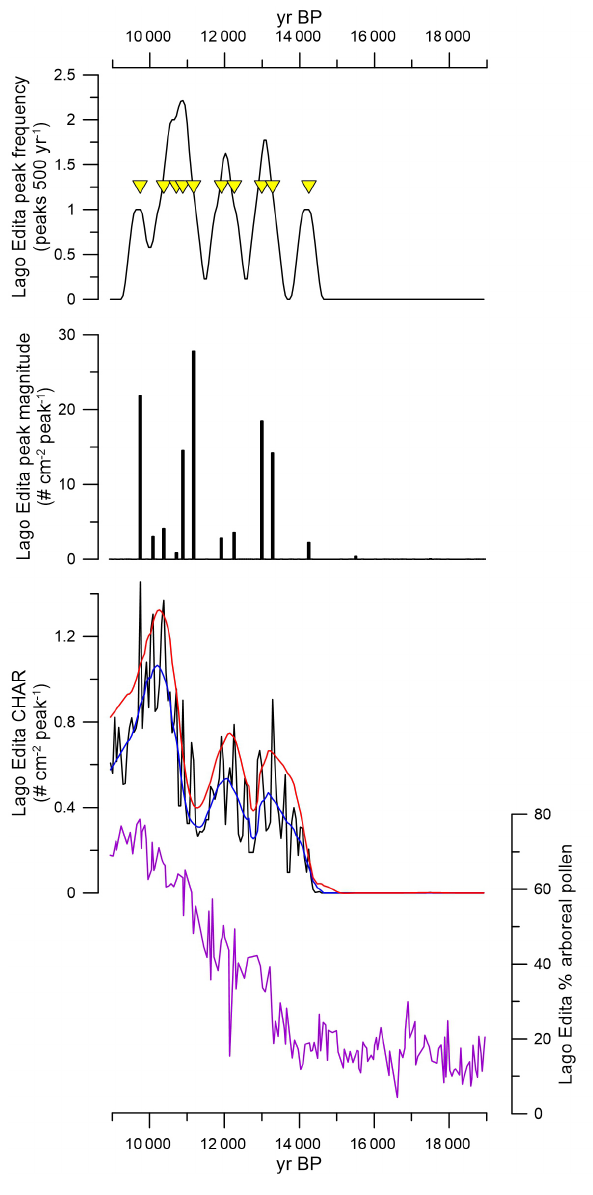
Figure 5. Macroscopic charcoal record from the Lago Edita core and results of CharAnalysis: the blue line is the background com- ponent, the red line is the locally defined threshold, triangles are statistically significant charcoal peaks and magnitude is the resid- ual abundance that supersedes the threshold. CHAR is the charcoal accumulation